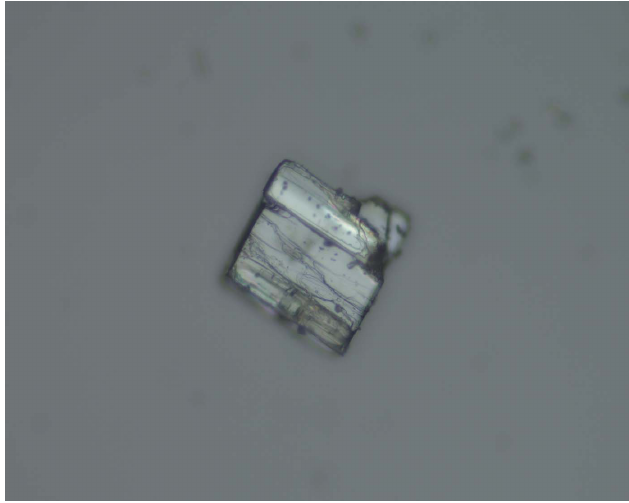
Figure 2 ( a ) Packing of the molecules in the title compound viewed along the a axis; ( b ) Chain sustained by bifurcated hydrogen bonds between the NH group and two carbonyl O atoms (blue dashed lines).